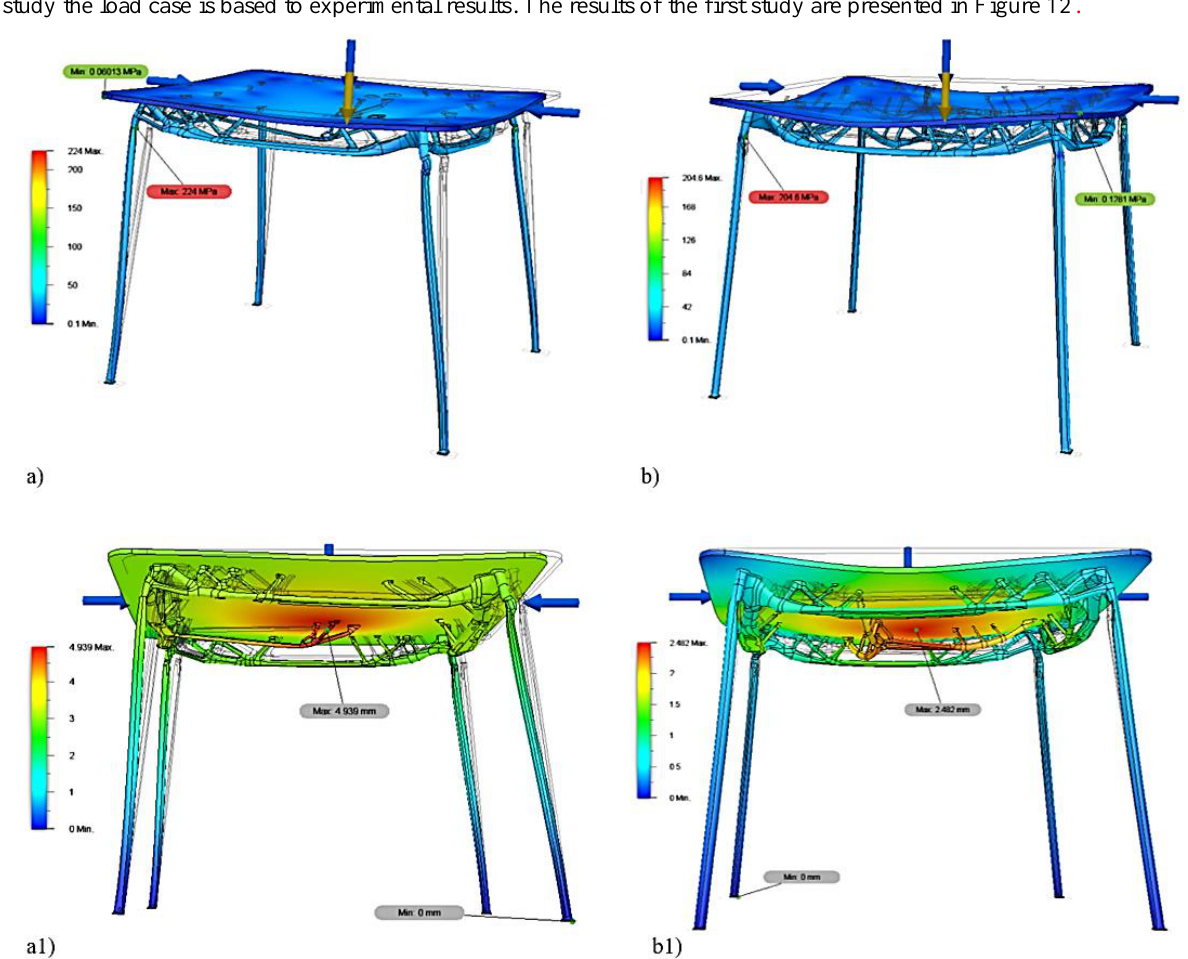
Figure 12. First FE analysis, the vertical force is 250 N and the horizontal forces are 30N each one. a) Von Misses Stress and; a1) Total displacement of the model_1; b) Von Misses Stress and; b1) Total displacement of the model_2. From the above results the model_1 (a) deformed permanently and fractured. In the model_2 the maximum stress is 10% less than the first model and deformed permanently. The total displacement in model_2 (b1) is 50% less than in the first model (a1). In general, model_2 is stiffer than model_1 but, in both models the weakest domain is the area where the legs start. Afterwards, we are going to perform two more FE analysis with lower vertical force. In first study the vertical force is 200N and in the second is 150N, the horizontal forces are 30N. The results from all three FE analysis are presented in Table